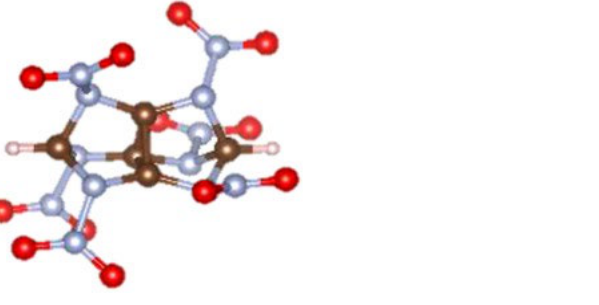
Figure 13. Molecular structure of molecule number164 [23]. Copyright 2021 Wiley-VCH GmbH.